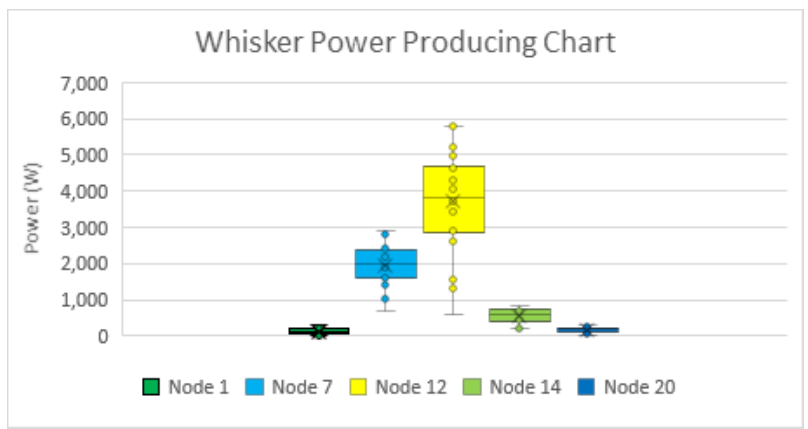
Figure 14. whisker power producing chart for each critical node. Figure 14. Whisker power producing chart for each critical